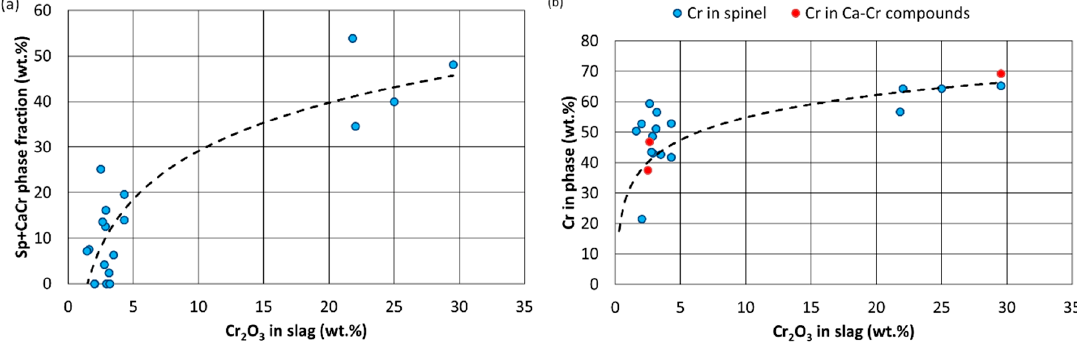
Figure 3. Cr-bearing phases fraction ( a ) and Cr concentration in Cr-bearing phases ( b ) as a function of Cr 2 O 3 concentration in the slag.